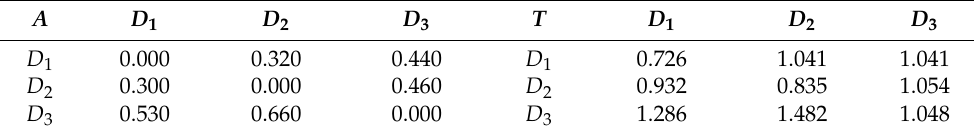
Table 4. The direct and total influence relations matrix of the dimensions.